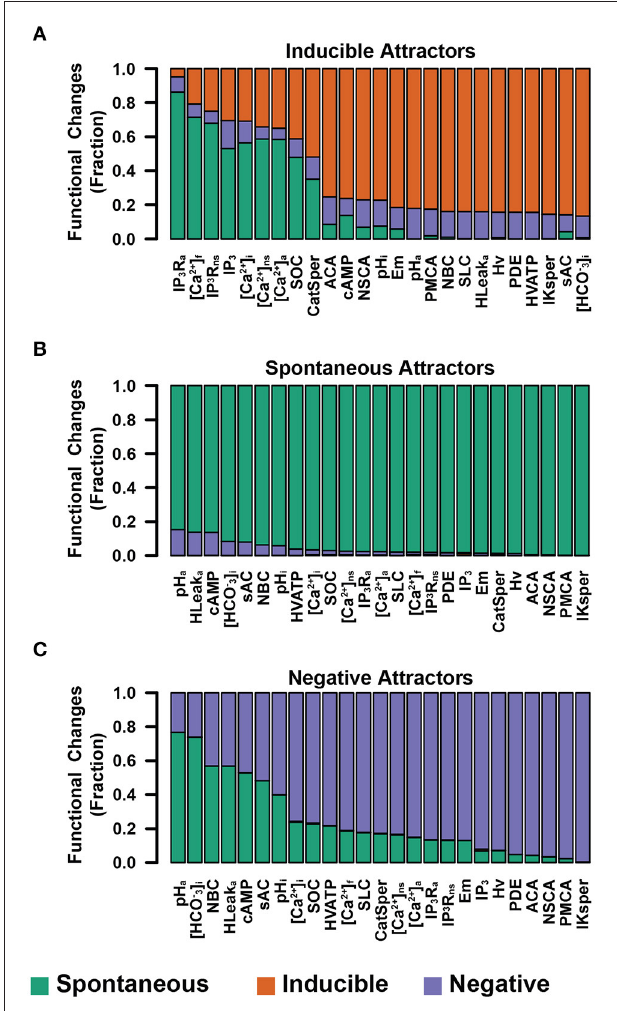
FIGURE 10 | Fraction of node-specific perturbations that promoted functional changes on Inducible (A) , Spontaneous (B) , and Negative (C) attractors. Nodes involved directly in [Ca 2 + ] i and [Ca 2 + ] a regulation show high sensitivity on the Inducible group, whereas Spontaneous and Negative attractors show higher sensitivity to perturbations to nodes related to pH a and pH i . The three panels show a minimal change into Inducible attractors from Negative and Spontaneous